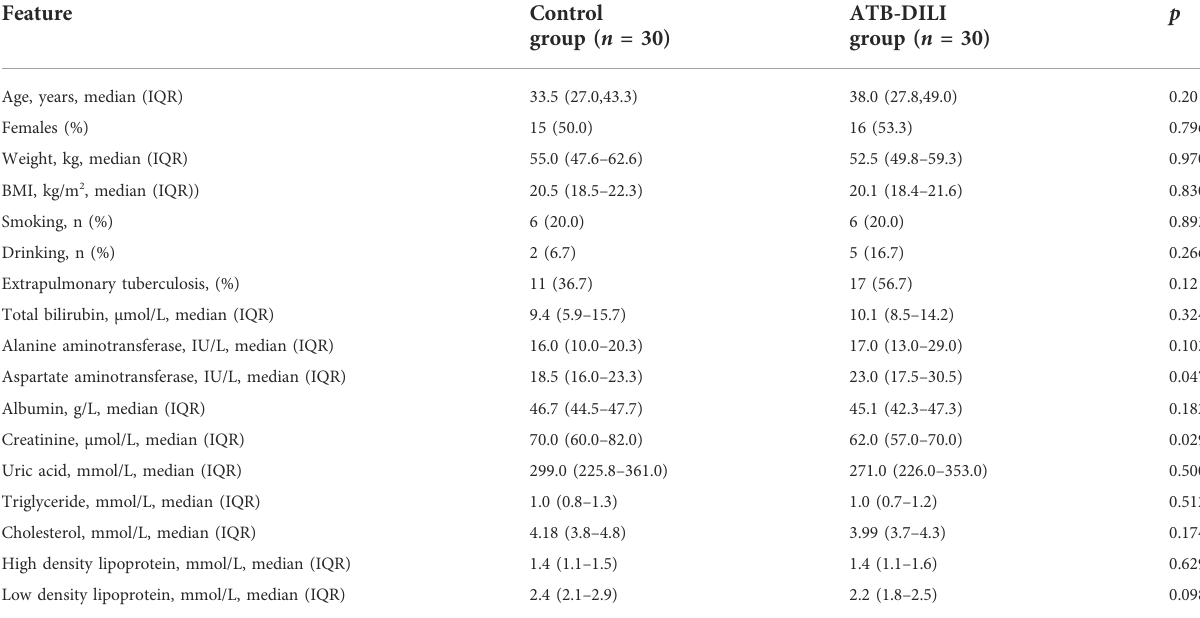
TABLE 1 Clinical characteristics of the two